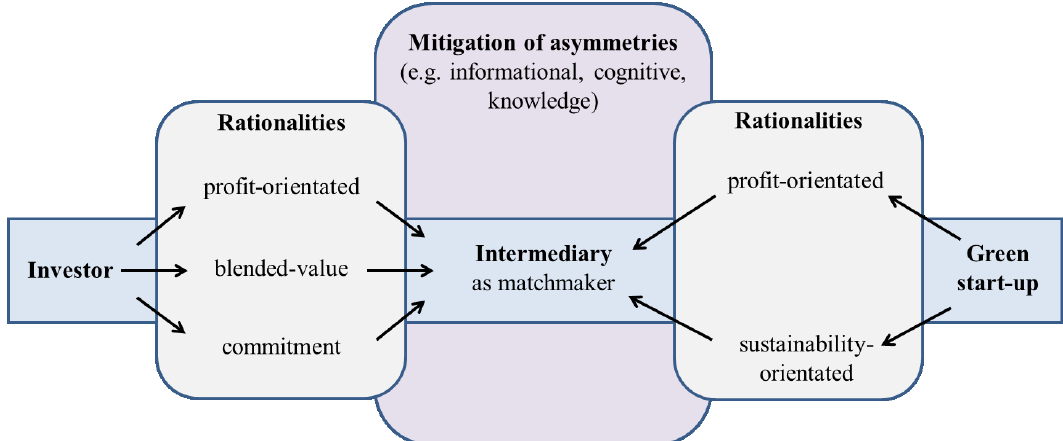
Figure 1. Framework for future research on green start-up finance with a broad conception of